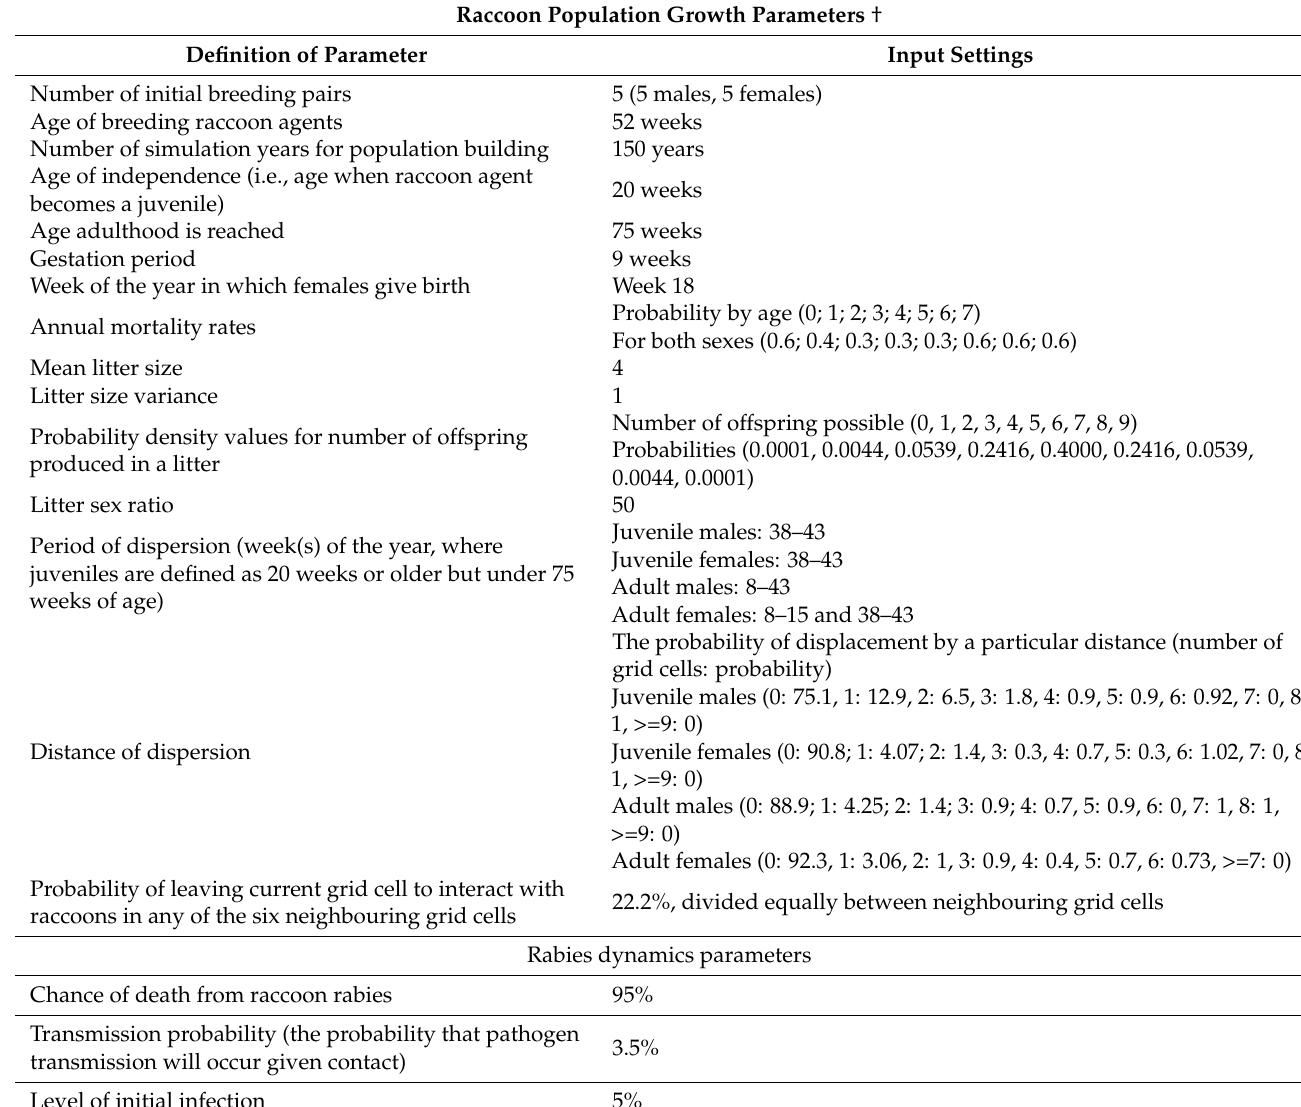
Table 1. SamPy parameters and inputs used for the raccoon population growth and rabies